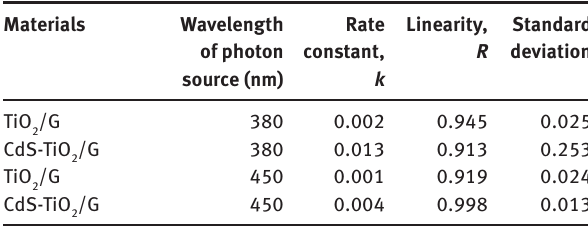
Table 2: First-order kinetics calculation of isopropanol degrada- tion with TiO /G and CdS-TiO /G. The kinetic analysis was based on 2 2 acetone production, which is defined by peak at 265 nm.